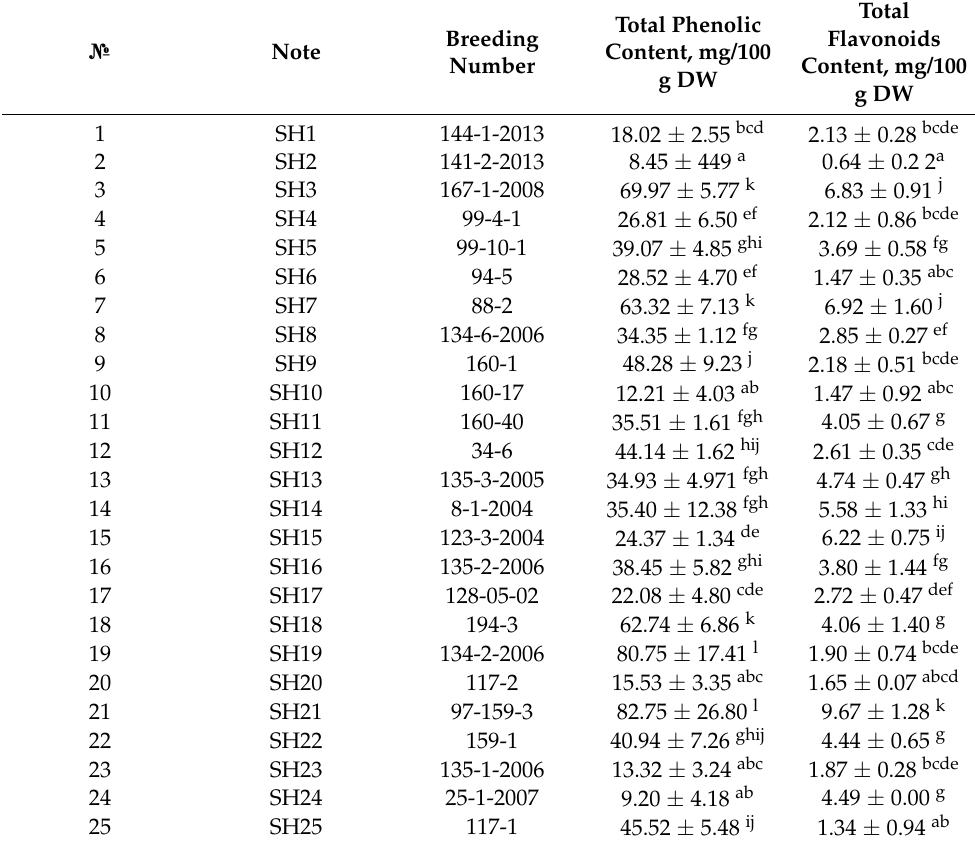
Table 3. Total phenolic and total flavonoids contents in potato hybrids